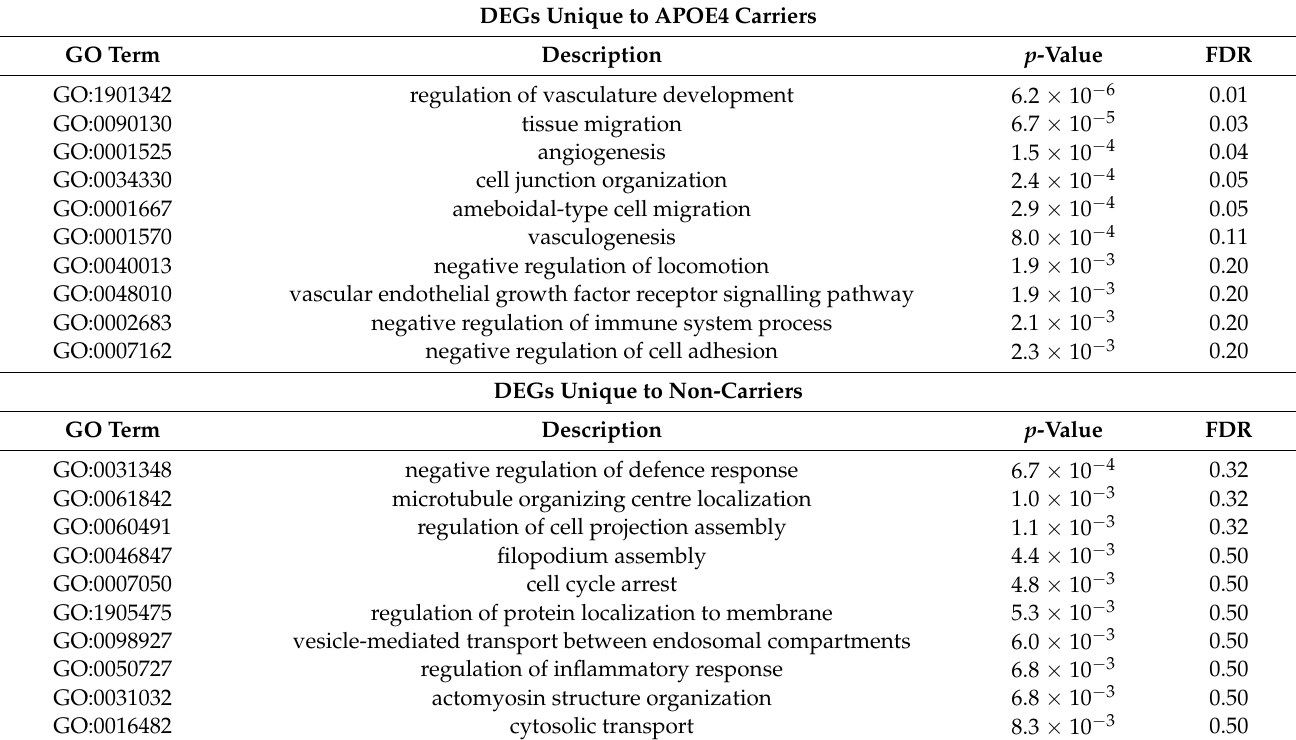
Table 7. Top 10 GO BP terms from enrichment analysis of the unique differentially expressed genes between dementia and no dementia groups in APOE4 carriers and